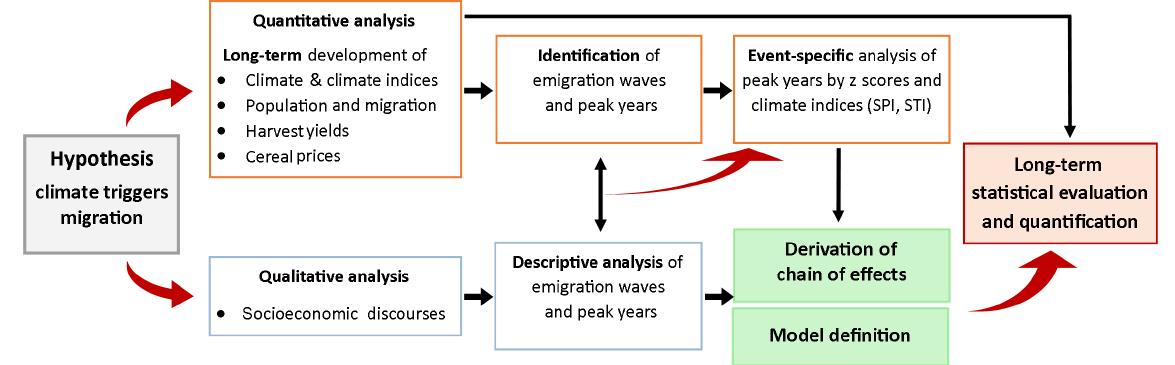
Figure 2. Framework for the evaluation of climatic, socioeconomic and agricultural influences on